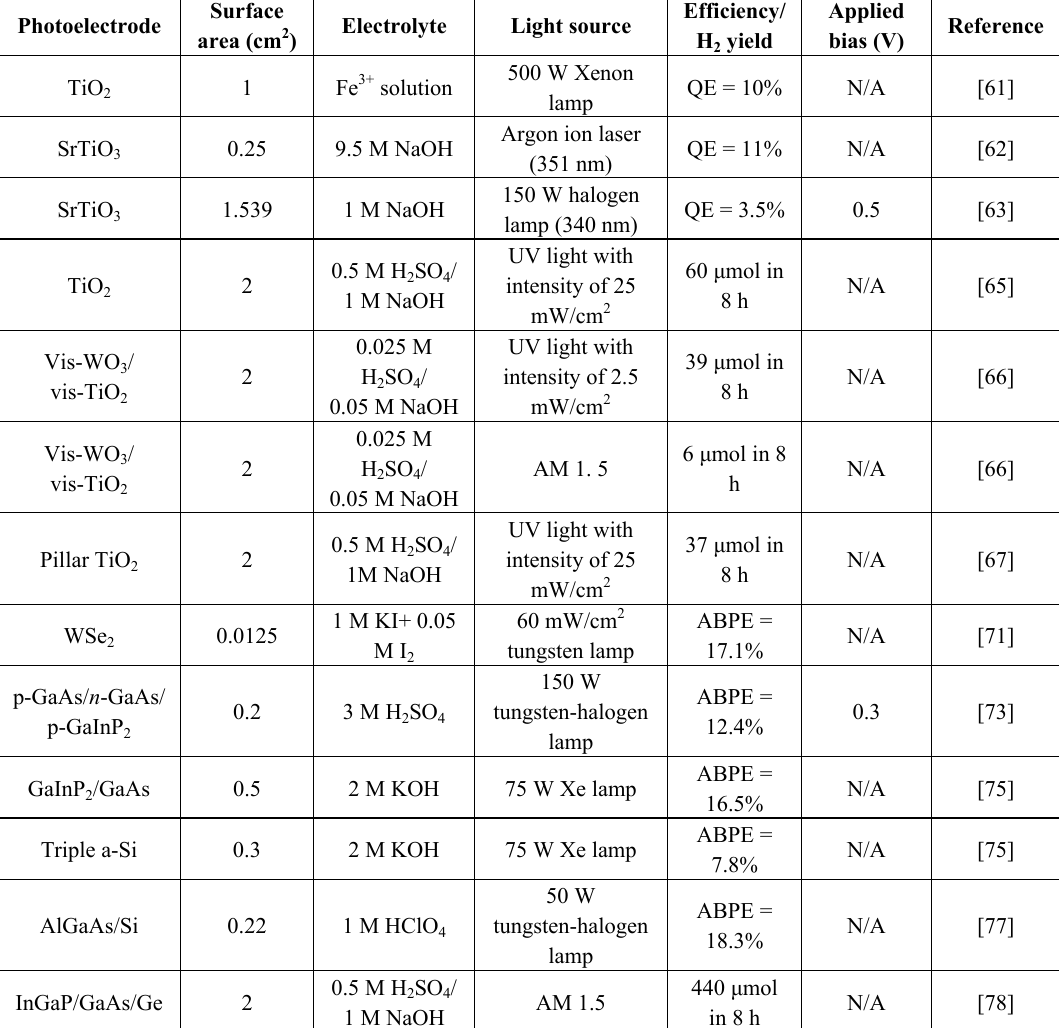
Table 2. Water splitting by photoelectrochemical-cell reaction over various